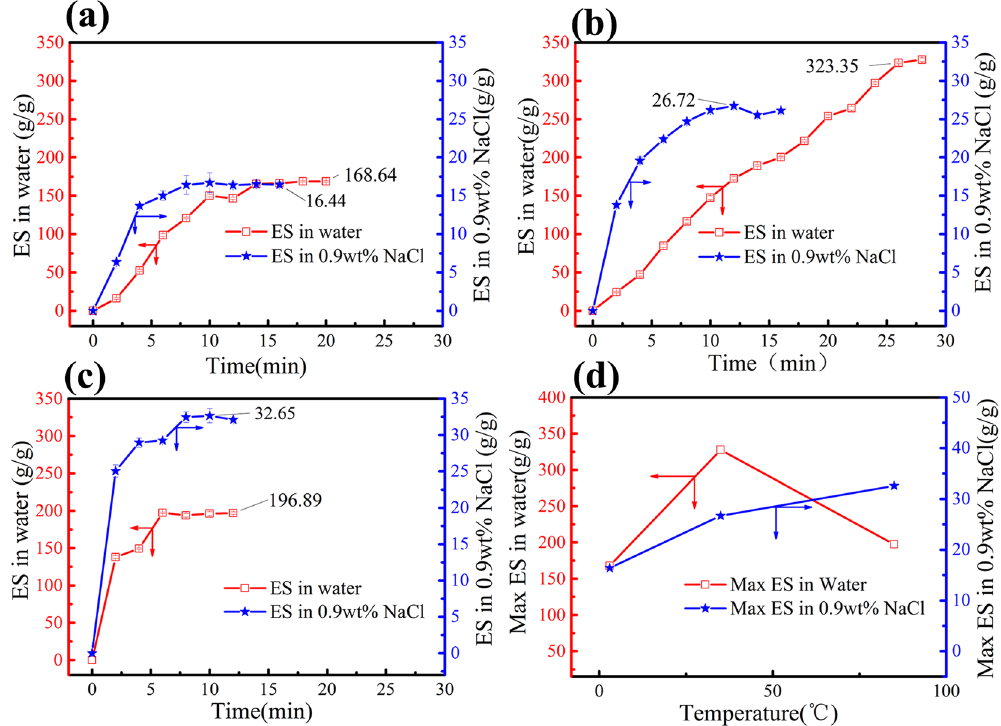
Figure 3. The temperature effect on the water absorbency, ( a ) 3 °C, ( b ) 35 °C, and ( c ) 85 °C (Data were given as means ± SD (n = 3)). ( d ) Max ES in water at 3 different